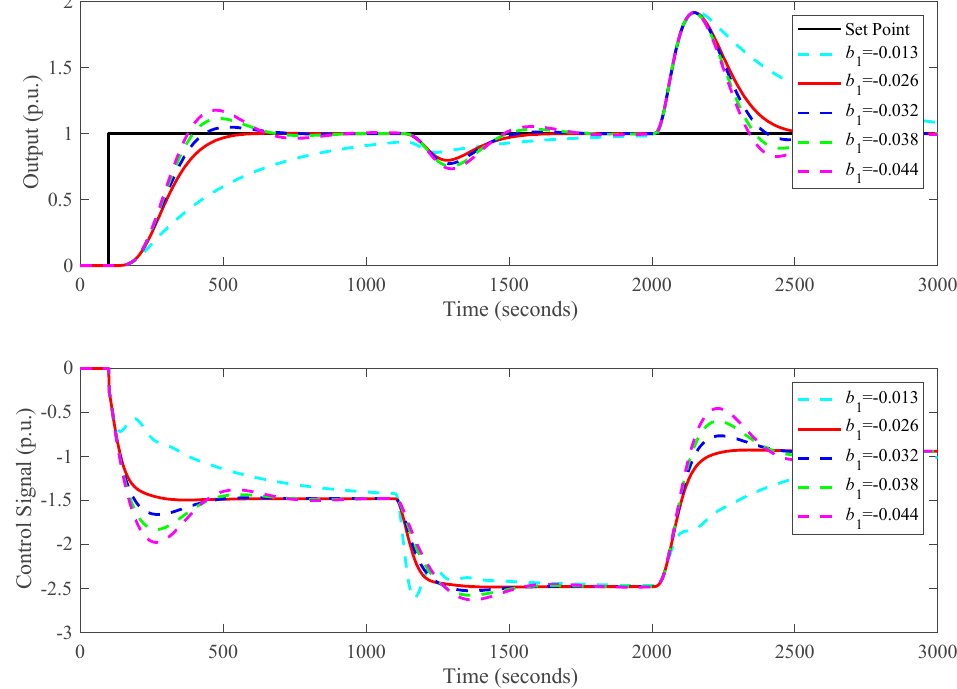
Figure 7. The influences on control performance with different b 1 .